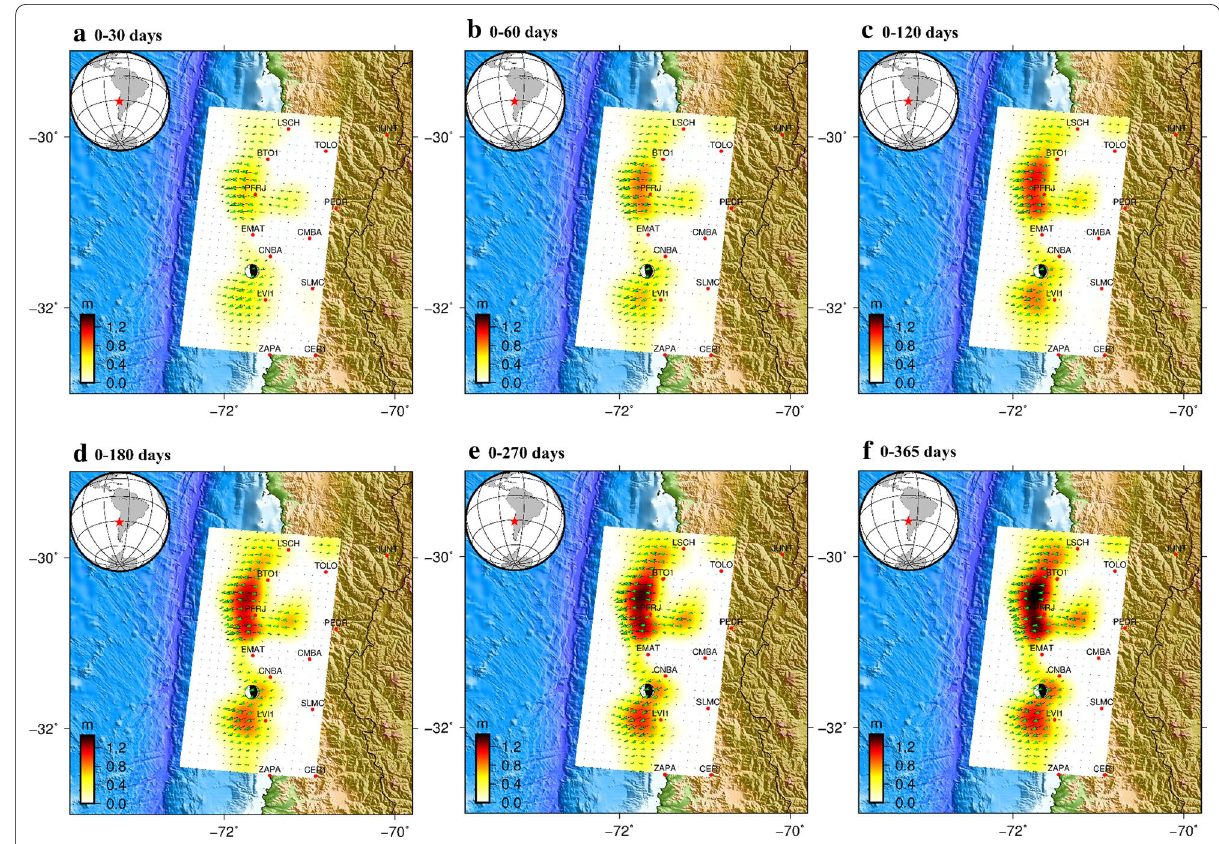
Fig. 9 Spatial–temporal evolution of afterslip associated with this earthquake